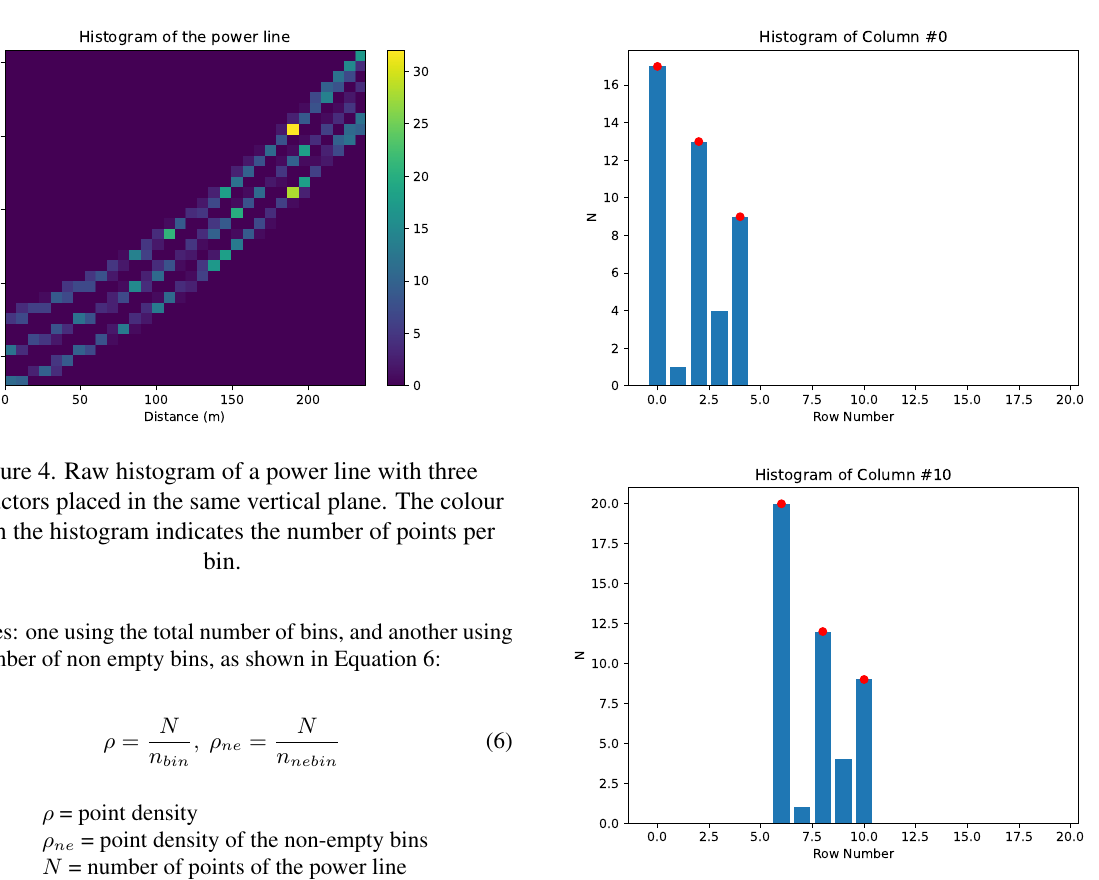
Figure 5. Histogram of columns 0 and 10. The red points represent a detected